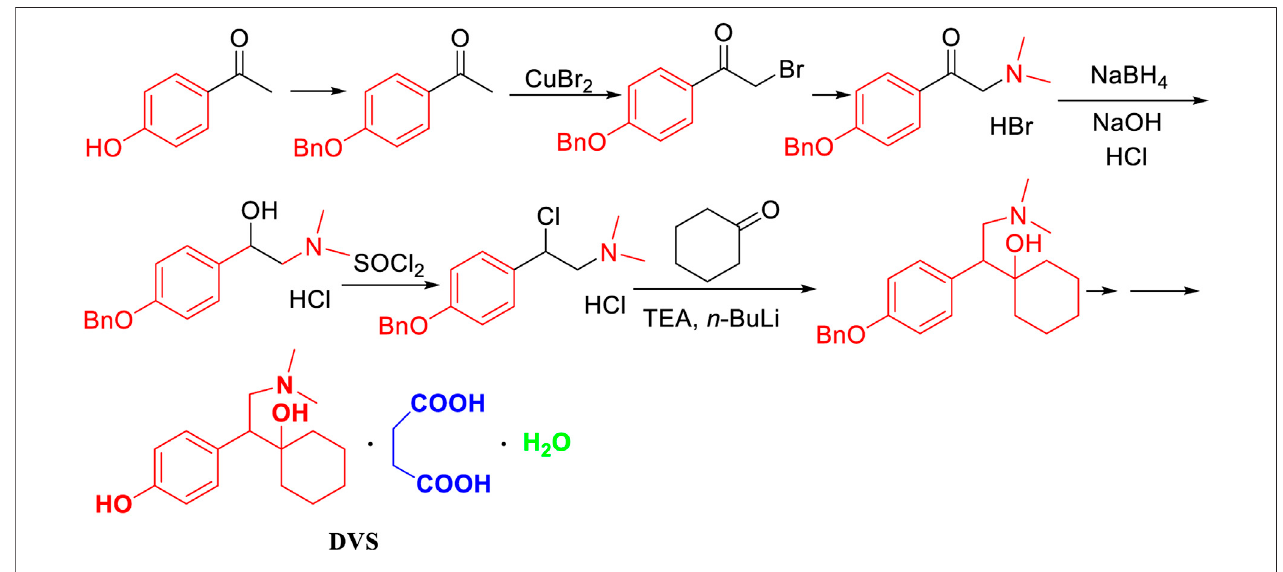
FIGURE 3 | The synthesis of desvenlafaxine from p-hydroxyacetophenone.